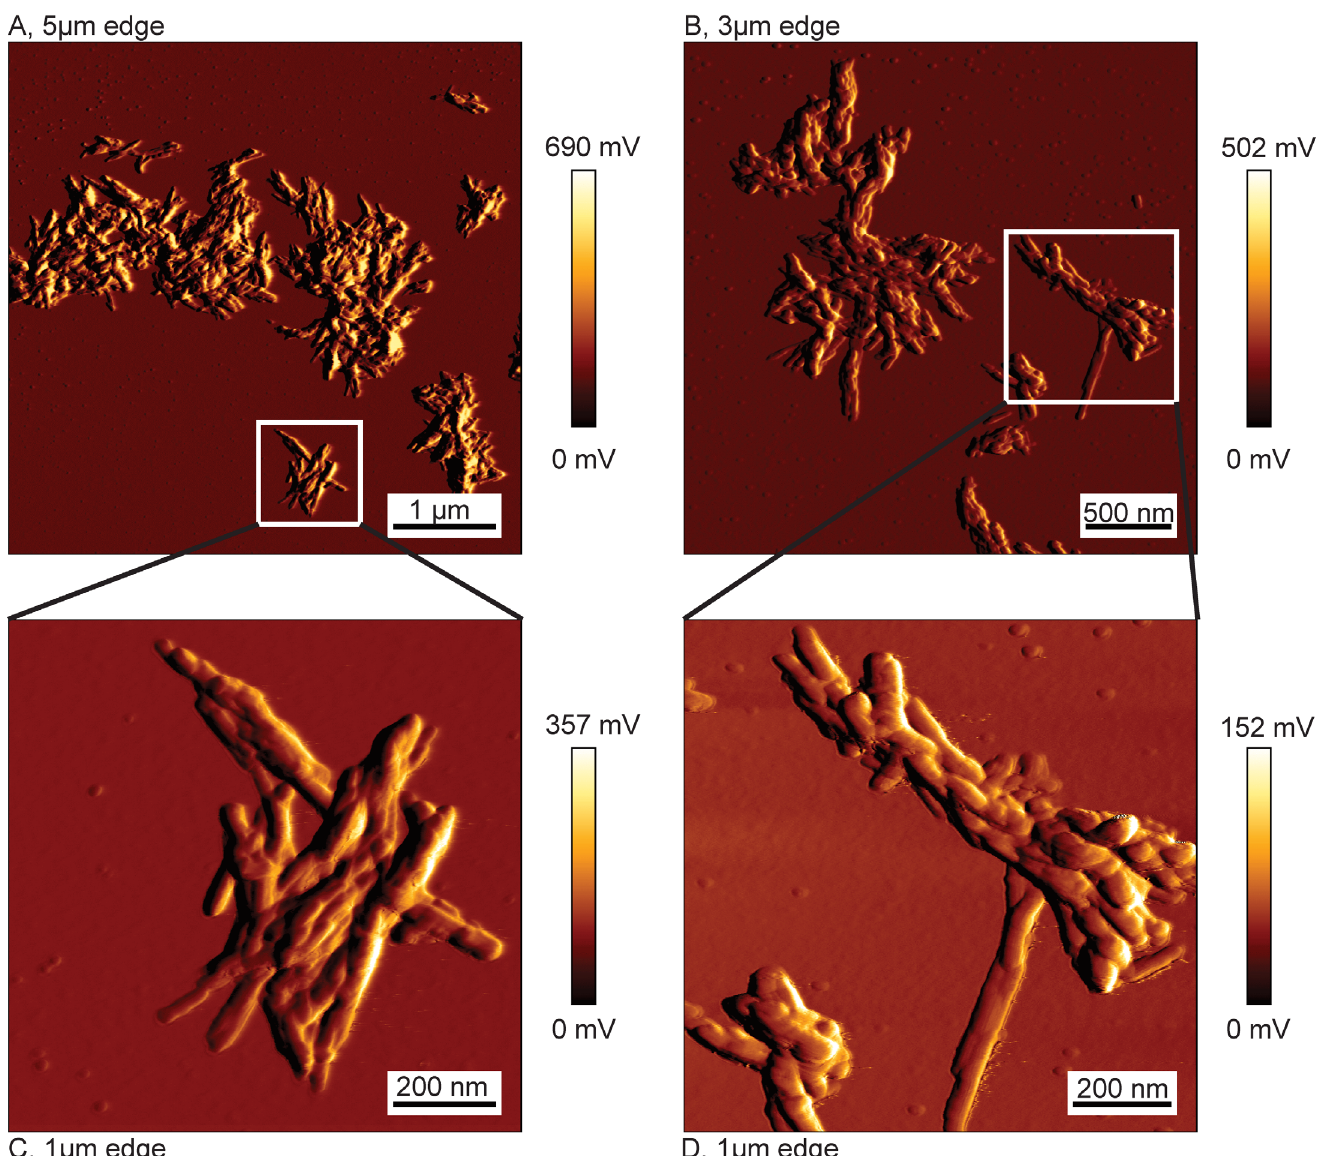
Fig 1. Atomic force micrographs of IAPP after fibrillation. Shown are scans of two different areas of the sample (A, B). C and D are additional scans focusing on smaller regions of A and B. Each scan consists of 1024x1024 pixels. Fibrils appear to laterally assemble into